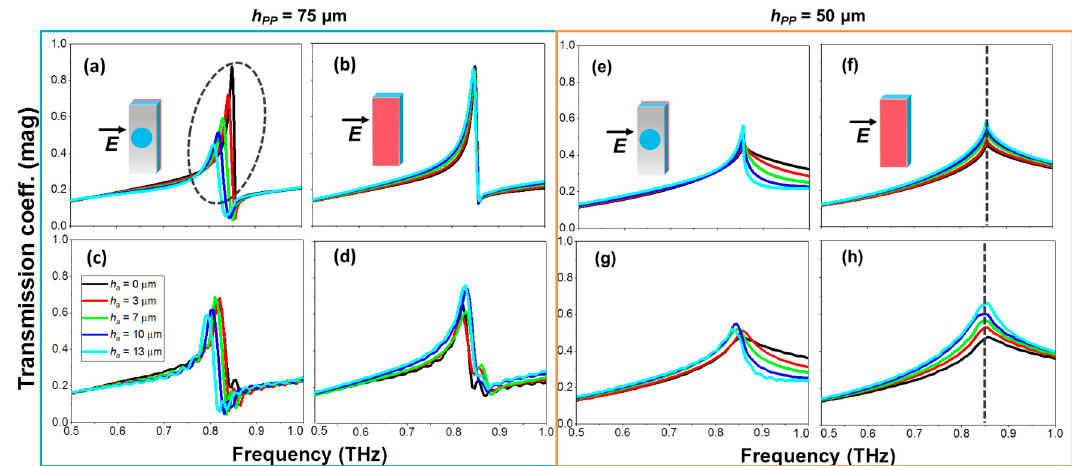
Figure 3. Transmission coefficient magnitude at the anomalous EOT regime in HA metasurfaces with h pp = 75 µ m ( a – d ) and h pp = 50 µ m ( e – f ) µ m under normal incidence and different analyte thicknesses: h a = 0 µ m (black); h a = 3 µ m (red); 7 µ m (green); 10 µ m (dark blue); 13 µ m (cyan) for the anomalous EOT. Simulated (top) and measured (bottom) results. The dashed ellipse in panel ( a ) highlights the region where sensing based on frequency shift is feasible. The dashed grey lines in panels ( f , h ) highlights the resonance frequency (0.85 THz) where the amplitude sensitivity analysis can be done. Insets in panels ( a , b , e , f ) depict schematically each scenario, following the colour convention of Figure 1.